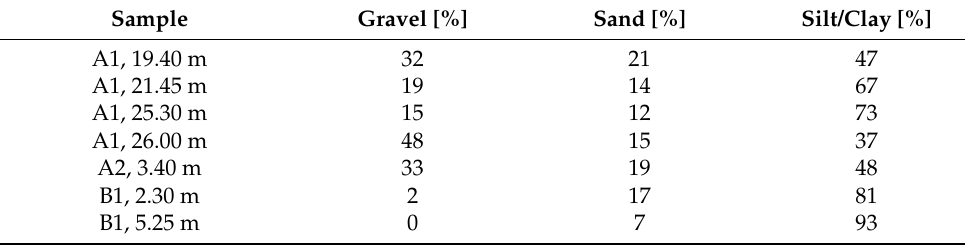
Table 2. Results of the sieving after DIN EN ISO 14688-1 (2020) [30].